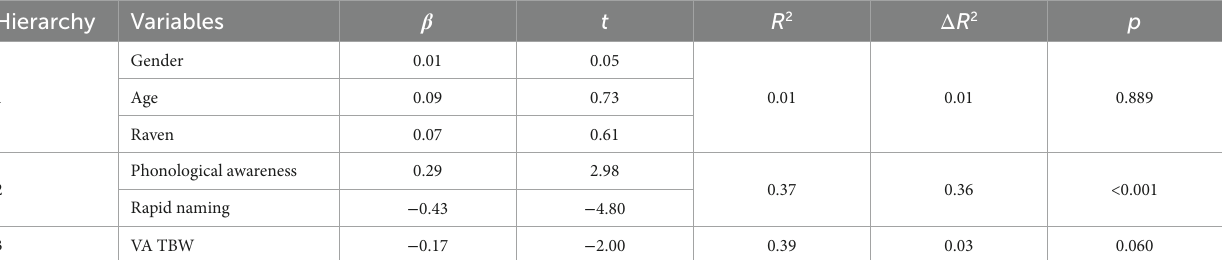
TABLE 3 Hierarchical regression of TBW on children’s reading fluency.